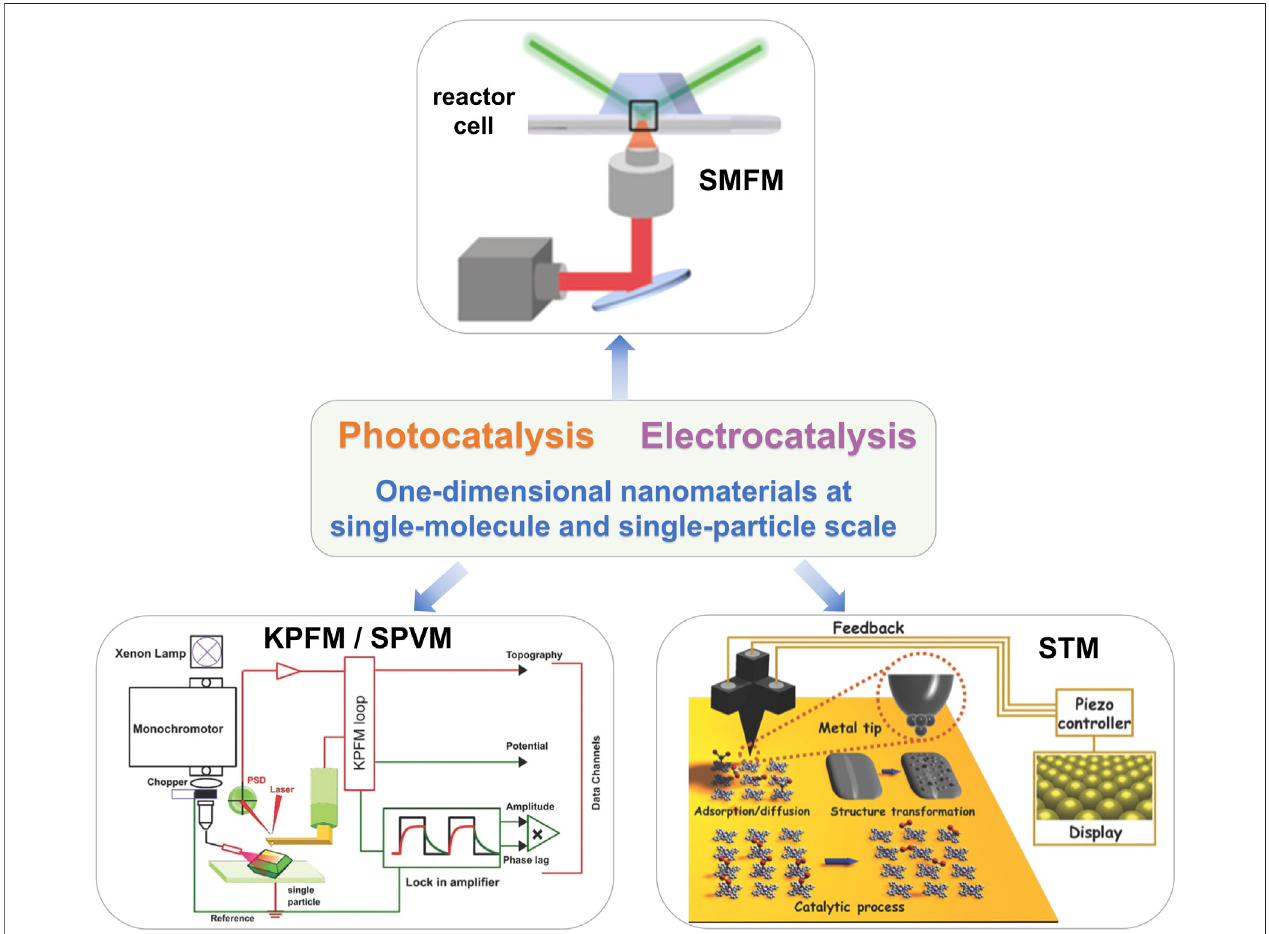
FIGURE 2 | The techniques for the investigation of 1D-nanomaterial catalysis at single-molecule and single-particle scale. The SMFM (Andoy et al., 2013), KPFM/ SPVM(Chenetal.,2018),andSTM(Wangetal.,2021)characterizationtoolswereintroducedinthisreview.ReproducedfromAndoyetal.(2013)withthepermissionof the American Chemical Society. Reproduced from Chen et al. (2018) with the permission of the Royal Society of Chemistry. Reproduced from Wang et al. (2021) with permission of the Royal Society of Chemistry.